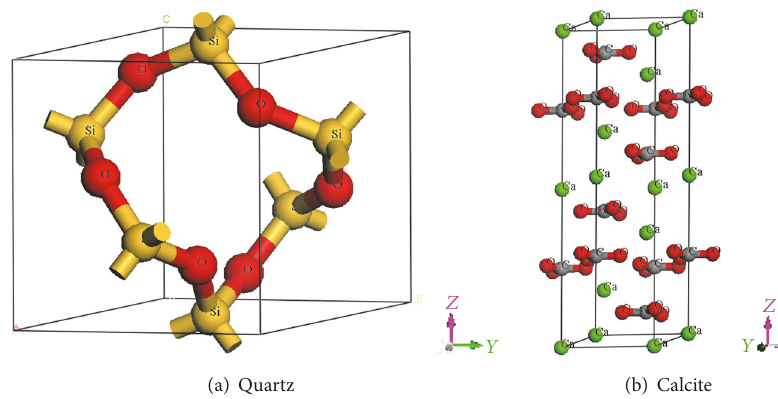
Figure 4: Unit cell diagram of the mineral crystals.